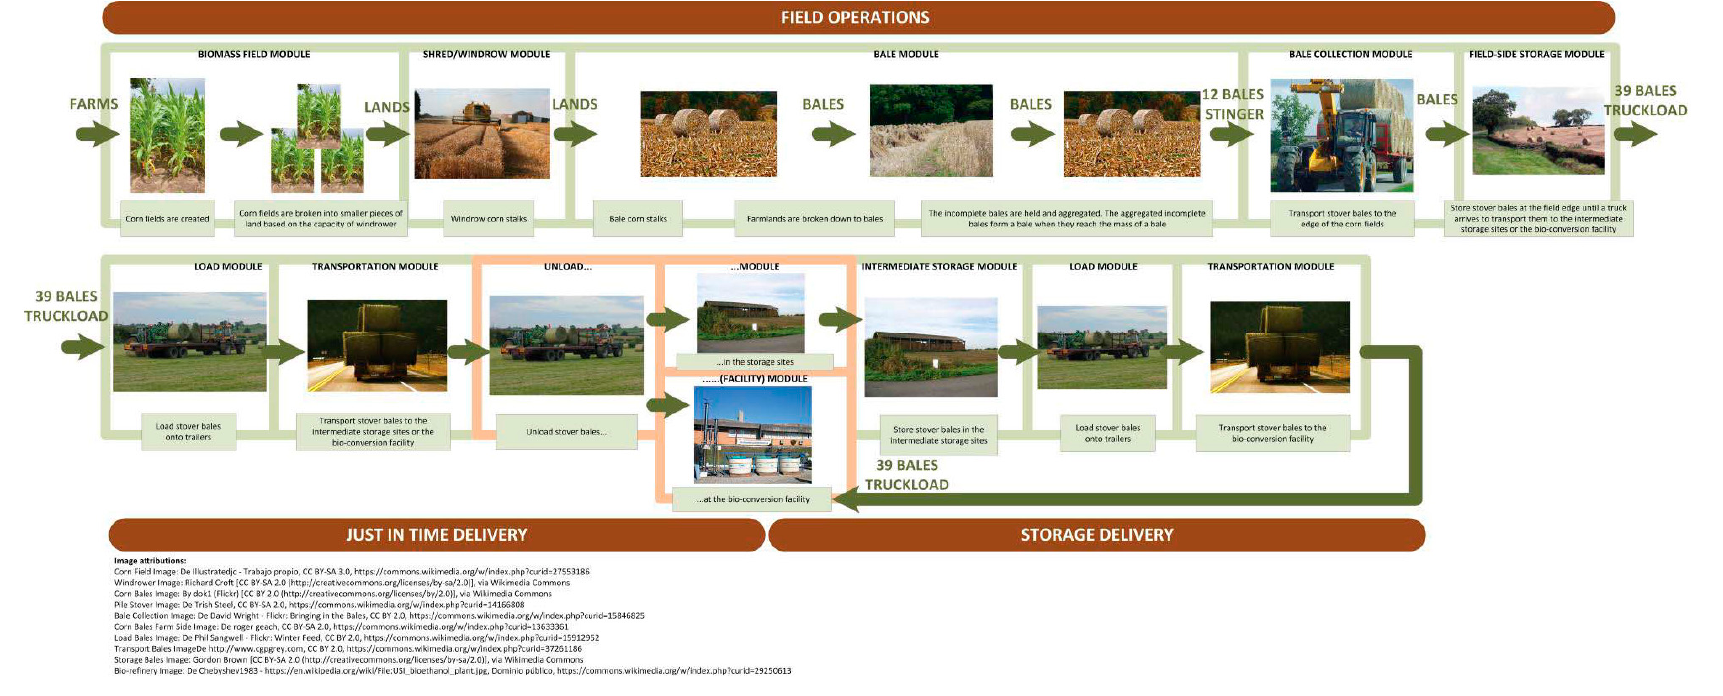
Figure 3. Corn stover SC for the production of bioethanol (IBSAL).